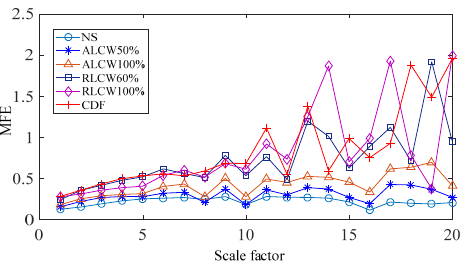
Figure 11. Change curves of the MFE values corresponding to different scale factors in different states.